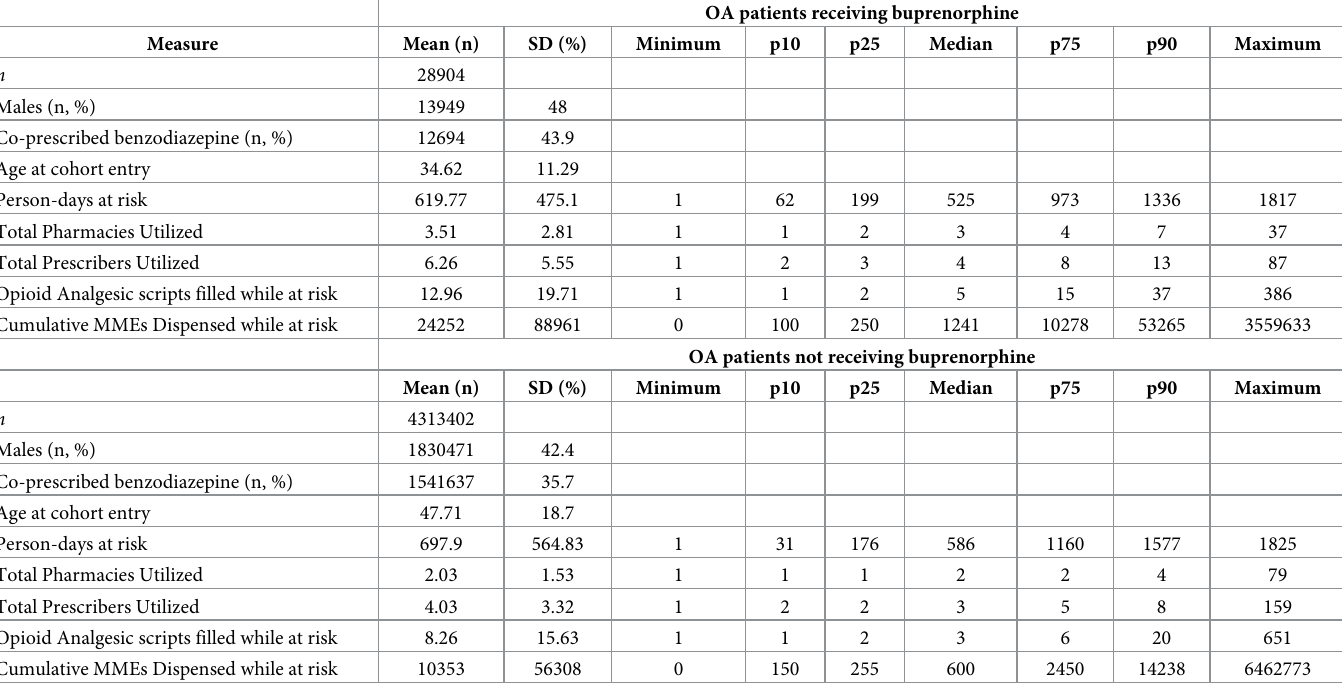
Table 1. Time-to-event analysis cohort of opioid analgesic patients in North Carolina,